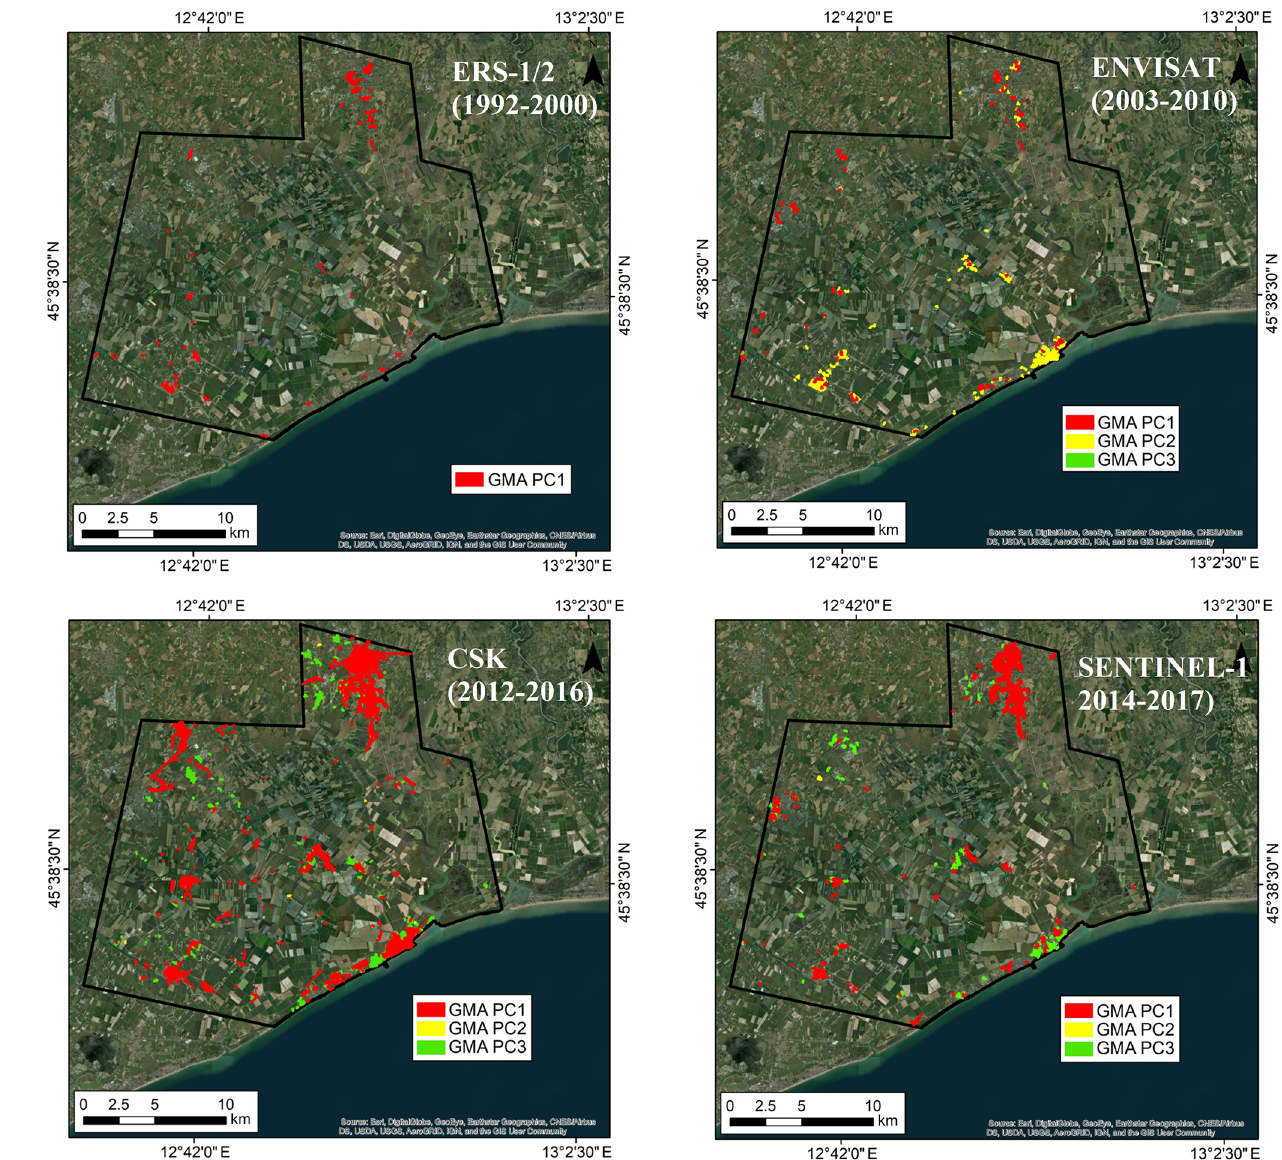
Figure 5. GMA detected in the different monitored